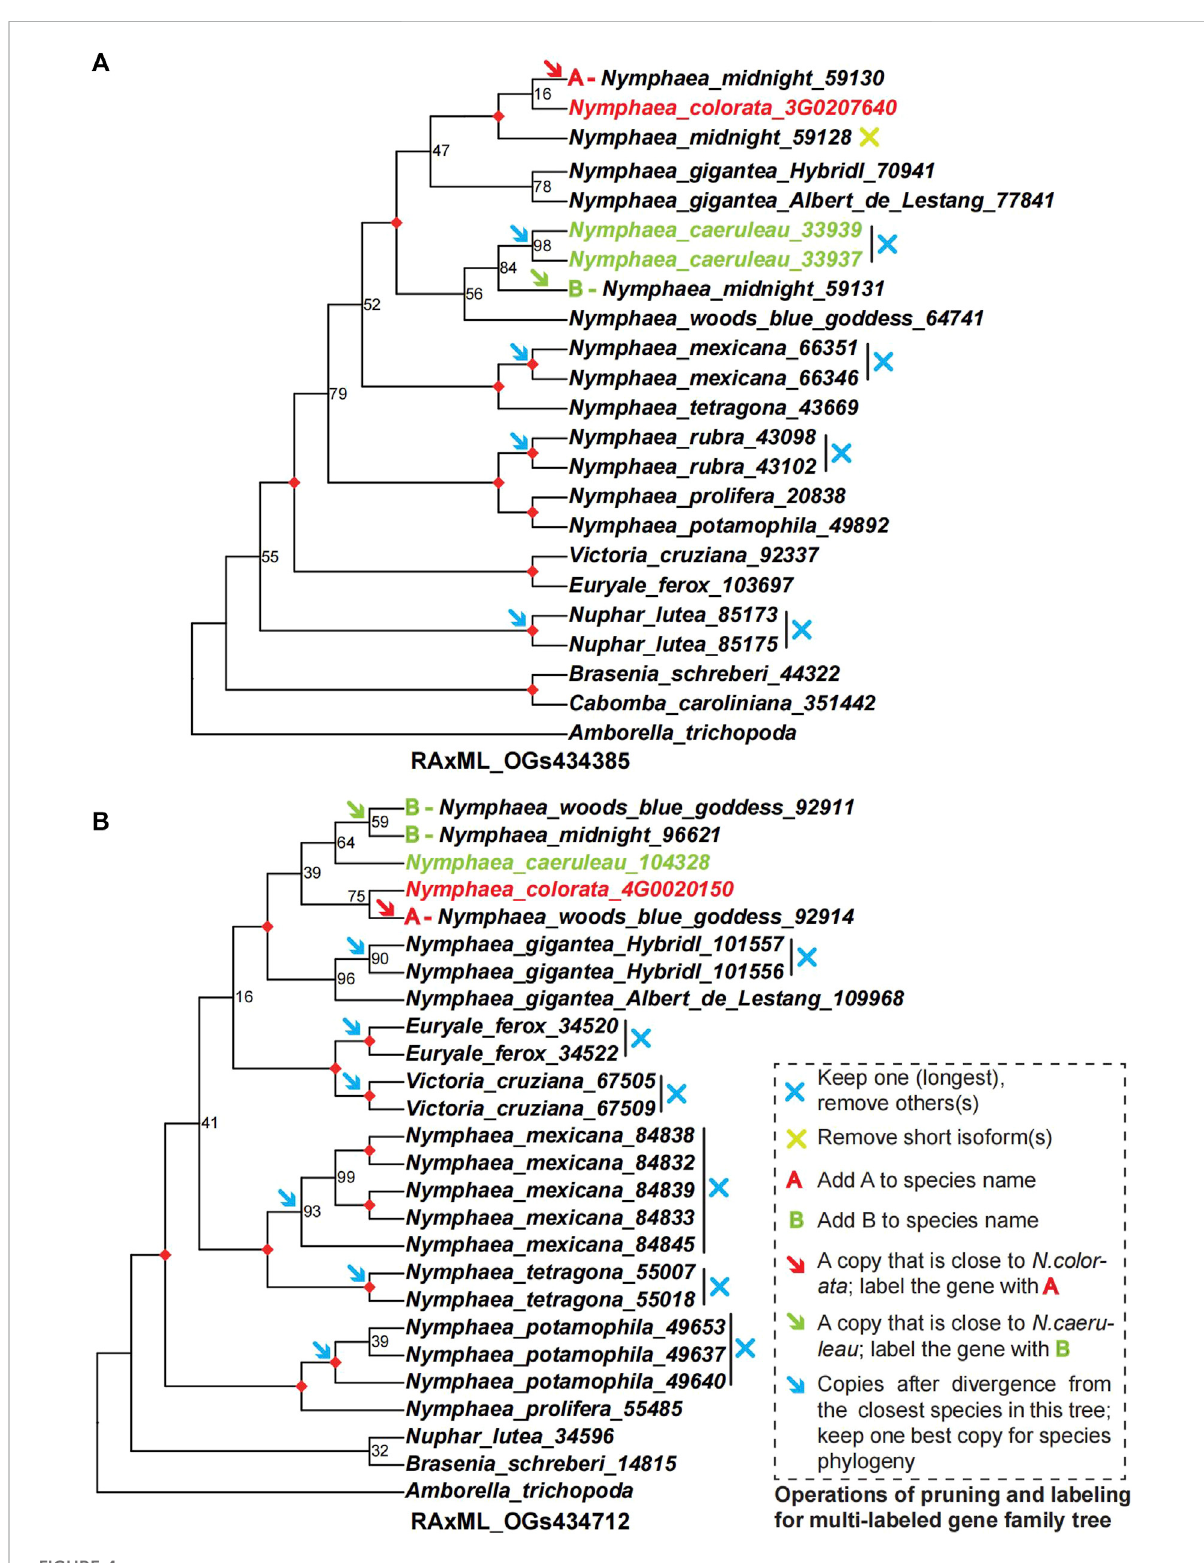
FIGURE 4 The examples of two gene family trees support a hybridization event and processing for pruning and labelling the multi-copy gene trees to multi-labeled gene trees as hybridization signals. (A,B) show two multi-copy gene family trees numbered RAxML_OGs434385 and